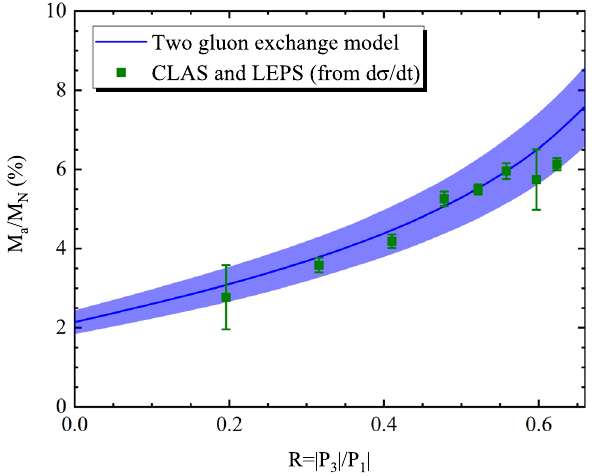
Fig. 4 The momentum transfers for the t min and t thr as a function of Fig. 2 The function of the trace anomaly contribution with R based W for the reaction of γ p → φ p . The blue line is for the t = t min , and of φ predicted by the on the differential cross section d σ/ dt | t = t the red dashed line is for the t = t thr min two gluon exchange model (the blue line). The olive-green squares are extracted from the CLAS [23] and LEPS [22]. Compared with the result obtained by heavy vector meson photoproduction, the extraction of M a / M N fromthe φ photoproductionisrelativelyflatwiththechange the trace anomaly is very sensitive and dependent on of energy. Here, the blue band is the error bar of A 0